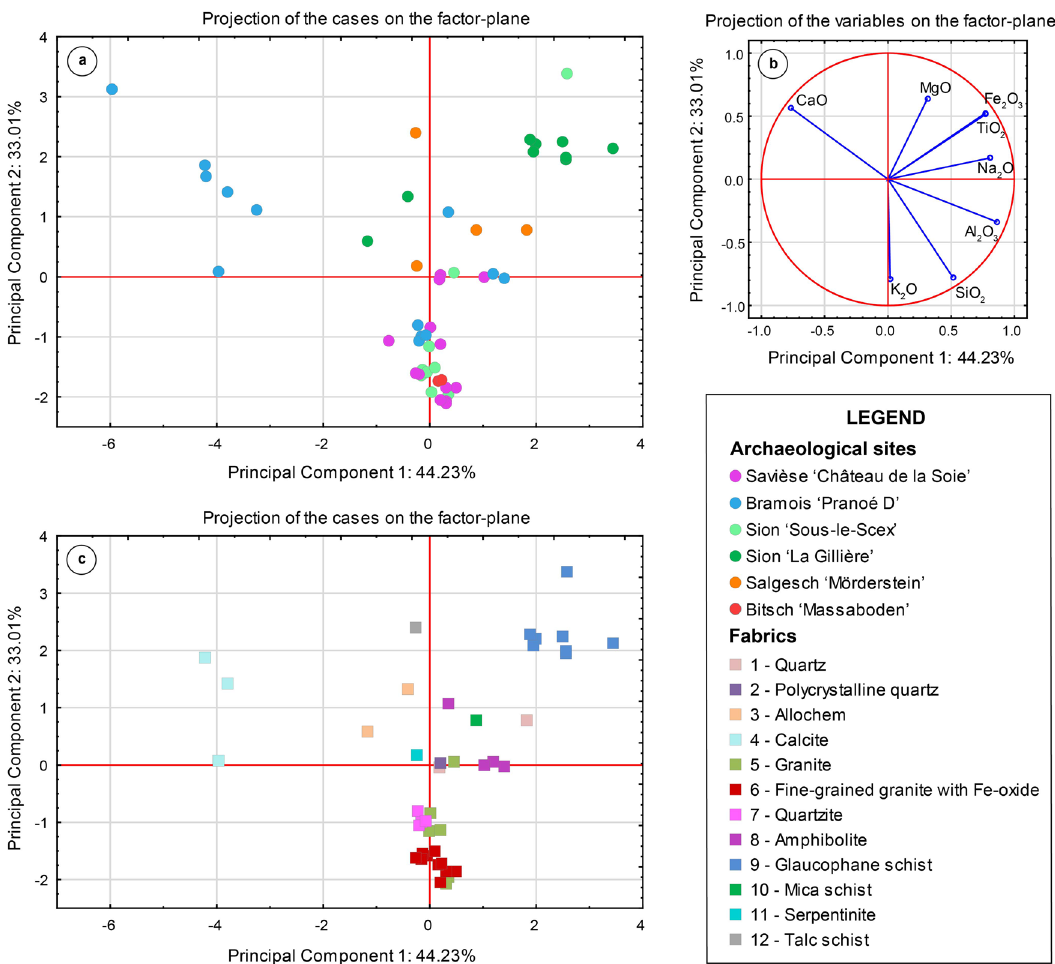
Figure 7: Statistical treatments of geochemical data of analyzed pottery: ( a ) and ( b ) PCA performed considering major and minor element content ( Supplementary material 2 ) – principal component biplot; ( c ) same principal component biplot of ( a ) with indication of the